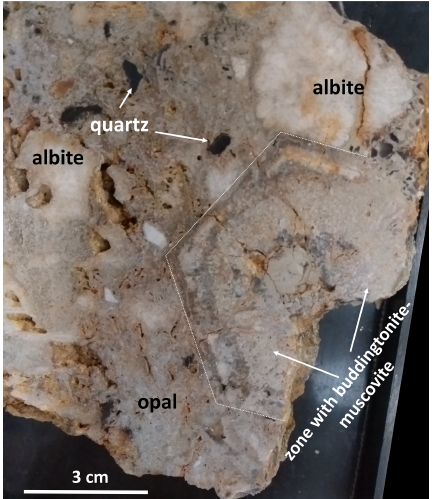
Figure 2. Photograph of the hand specimen (cut surface) with the investigated pseudomorph (outlined) of bertran- dite + muscovite + buddingtonite ± euclase in a breccia of pegmatitic minerals, cemented by opal.